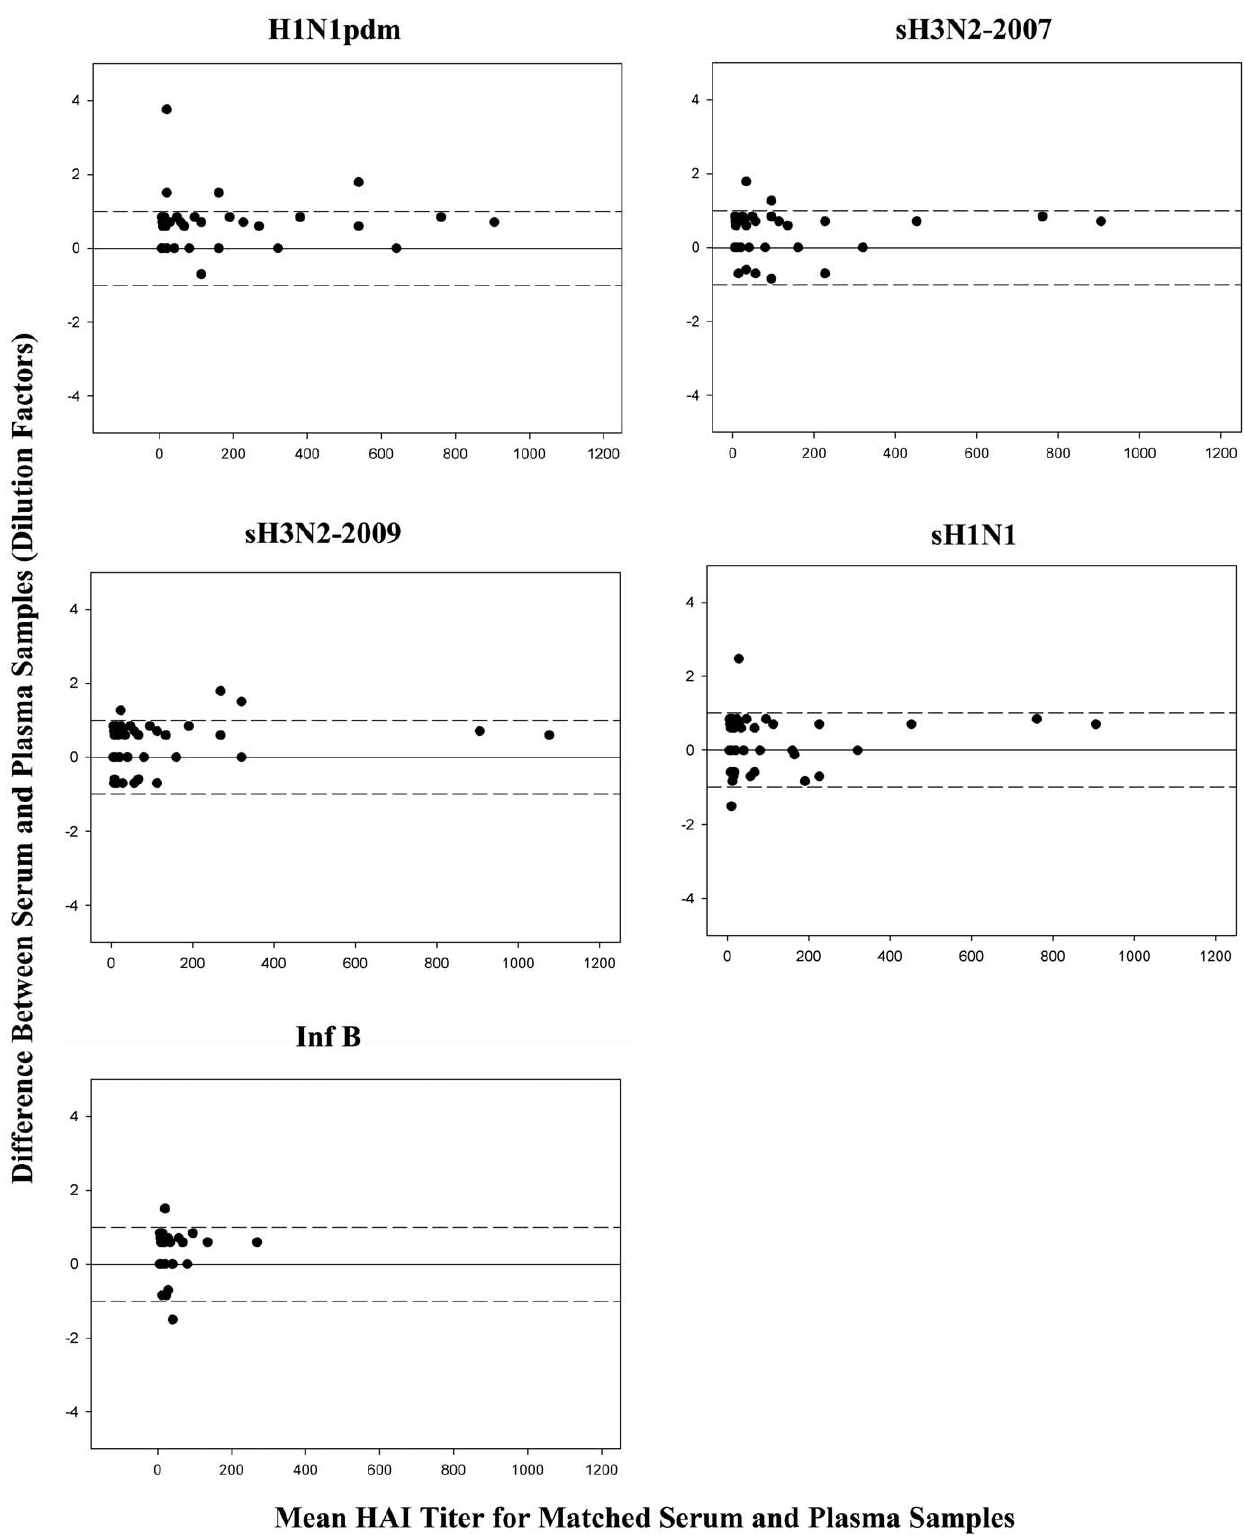
Figure 1. Bland-Altman Plots for 165 serum-citrated plasma samples. Dashed lines denote the limit of agreement (all HAI values within 1 dilution factor). Overall agreement between the serum and plasma samples was $ 97%.